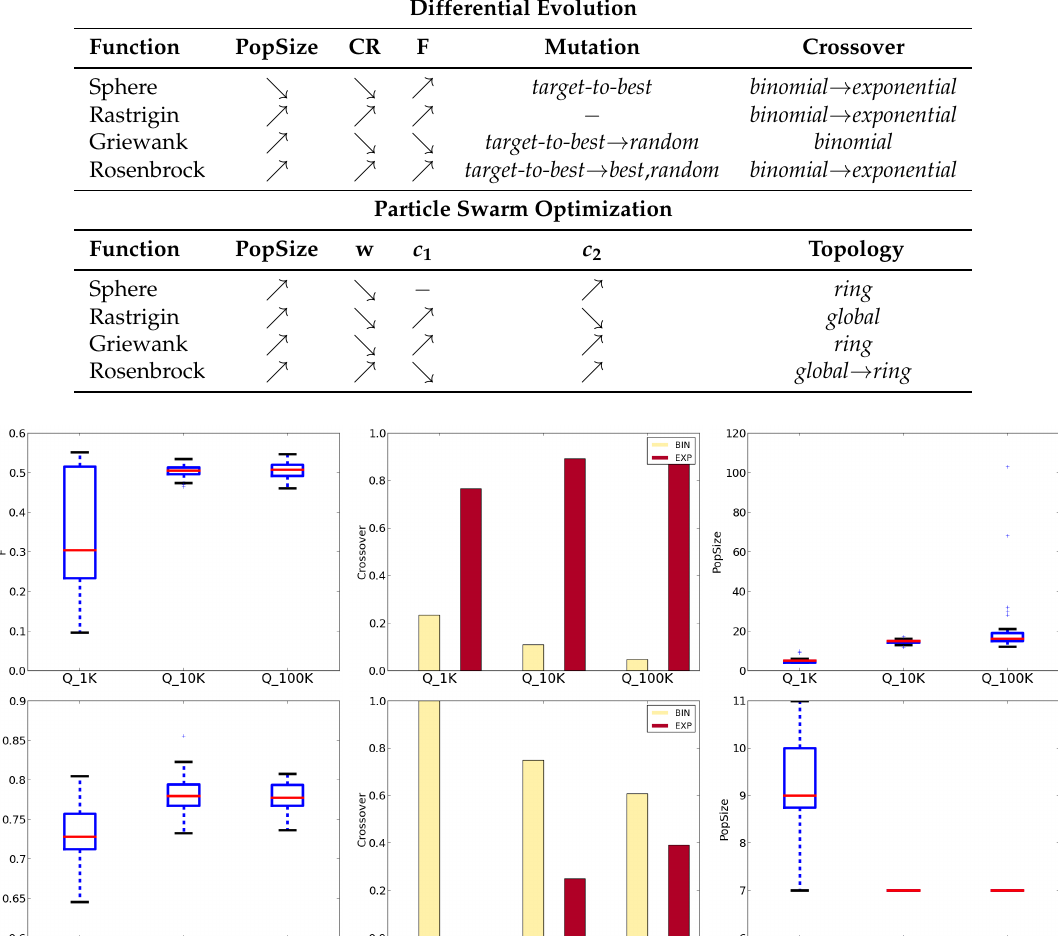
Table 3. Trends of DE and PSO parameter values versus fitness evaluations budget. Upward arrows denote parameter values increasing with the number of evaluations, downward arrows the opposite. A dash denotes no clear trend. For nominal parameters, the table reports the most frequently selected choice. If the choice changes within the top solutions for different evaluation budgets, an arrow shows the direction of this change as the budget increases.